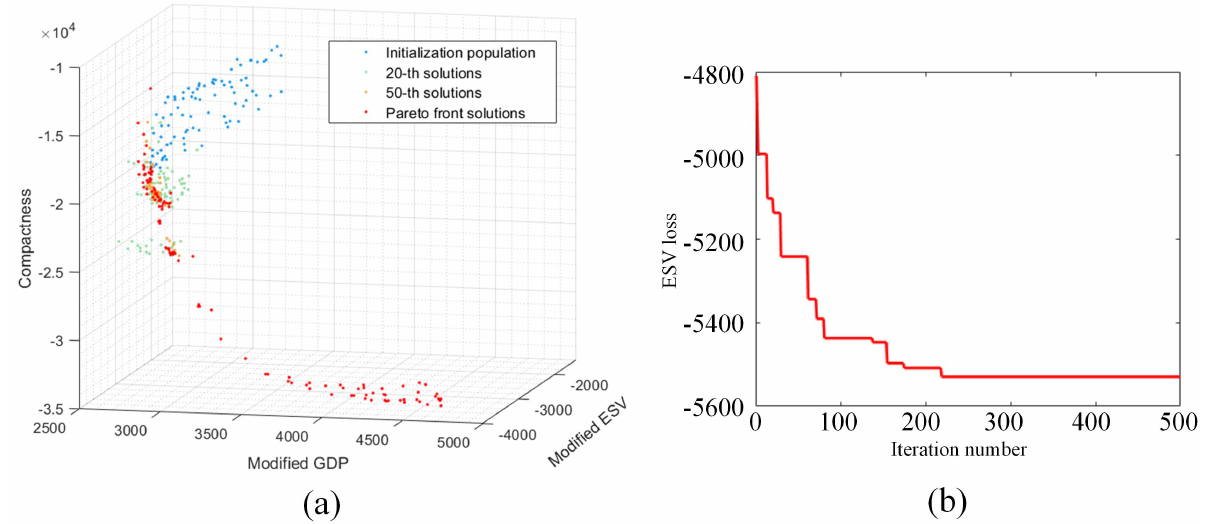
Figure 11. The joint distribution of three objectives ( a ), and the convergence curve of modified ESV change ( b ) with iteration. In ( a ), the objective values are shown at different iteration stages: the blue points represent the initial random population; the green and orange points represent the 20-th and 50-th generation solutions, respectively; the red points are the final result.